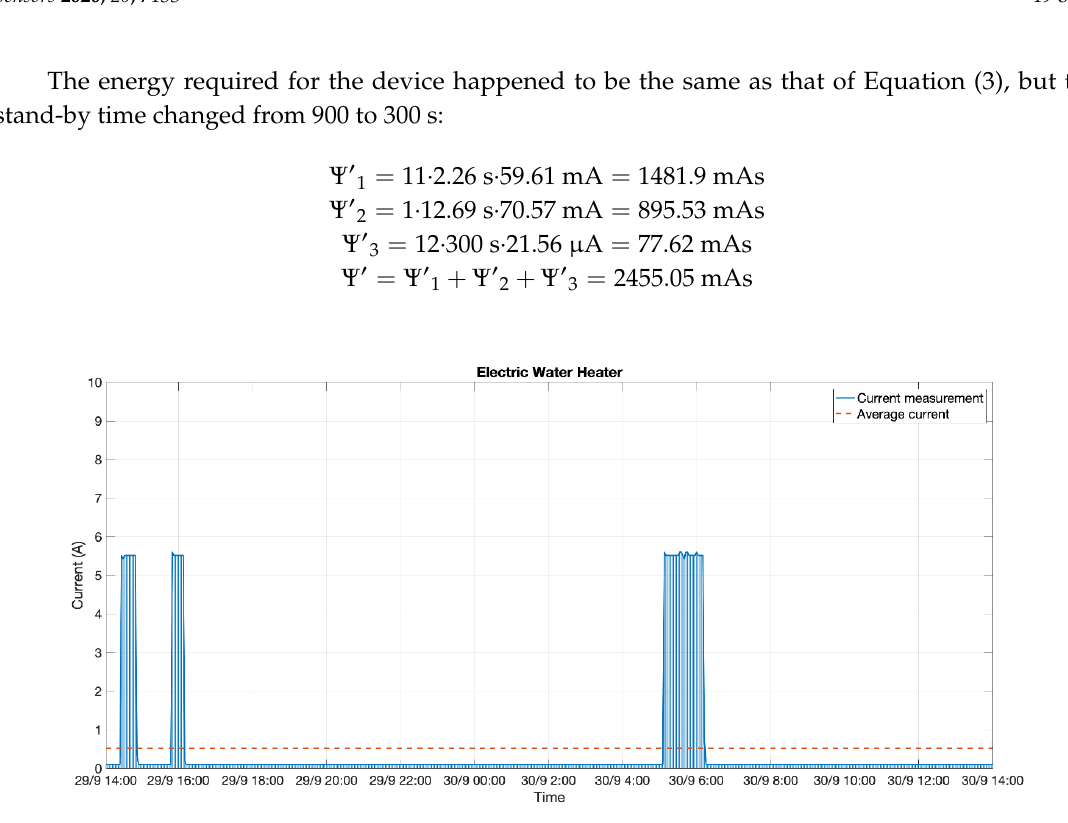
Figure 19. Electrical consumption of the water heater.